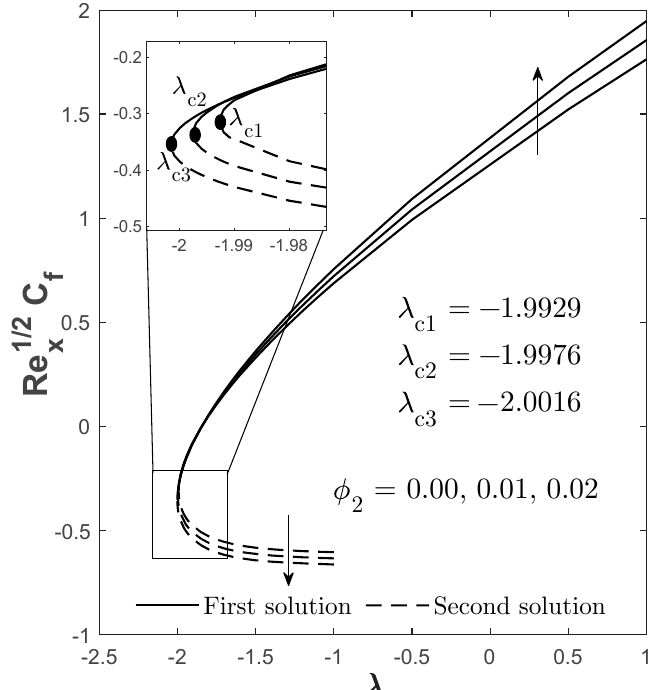
Figure 2. for varied Figure 2. Re 1/2 x C f for varied φ 2 when N = Rd = Sc = Sr = 1, Du = 0.03, and Bi = 0.1. Figure 2.